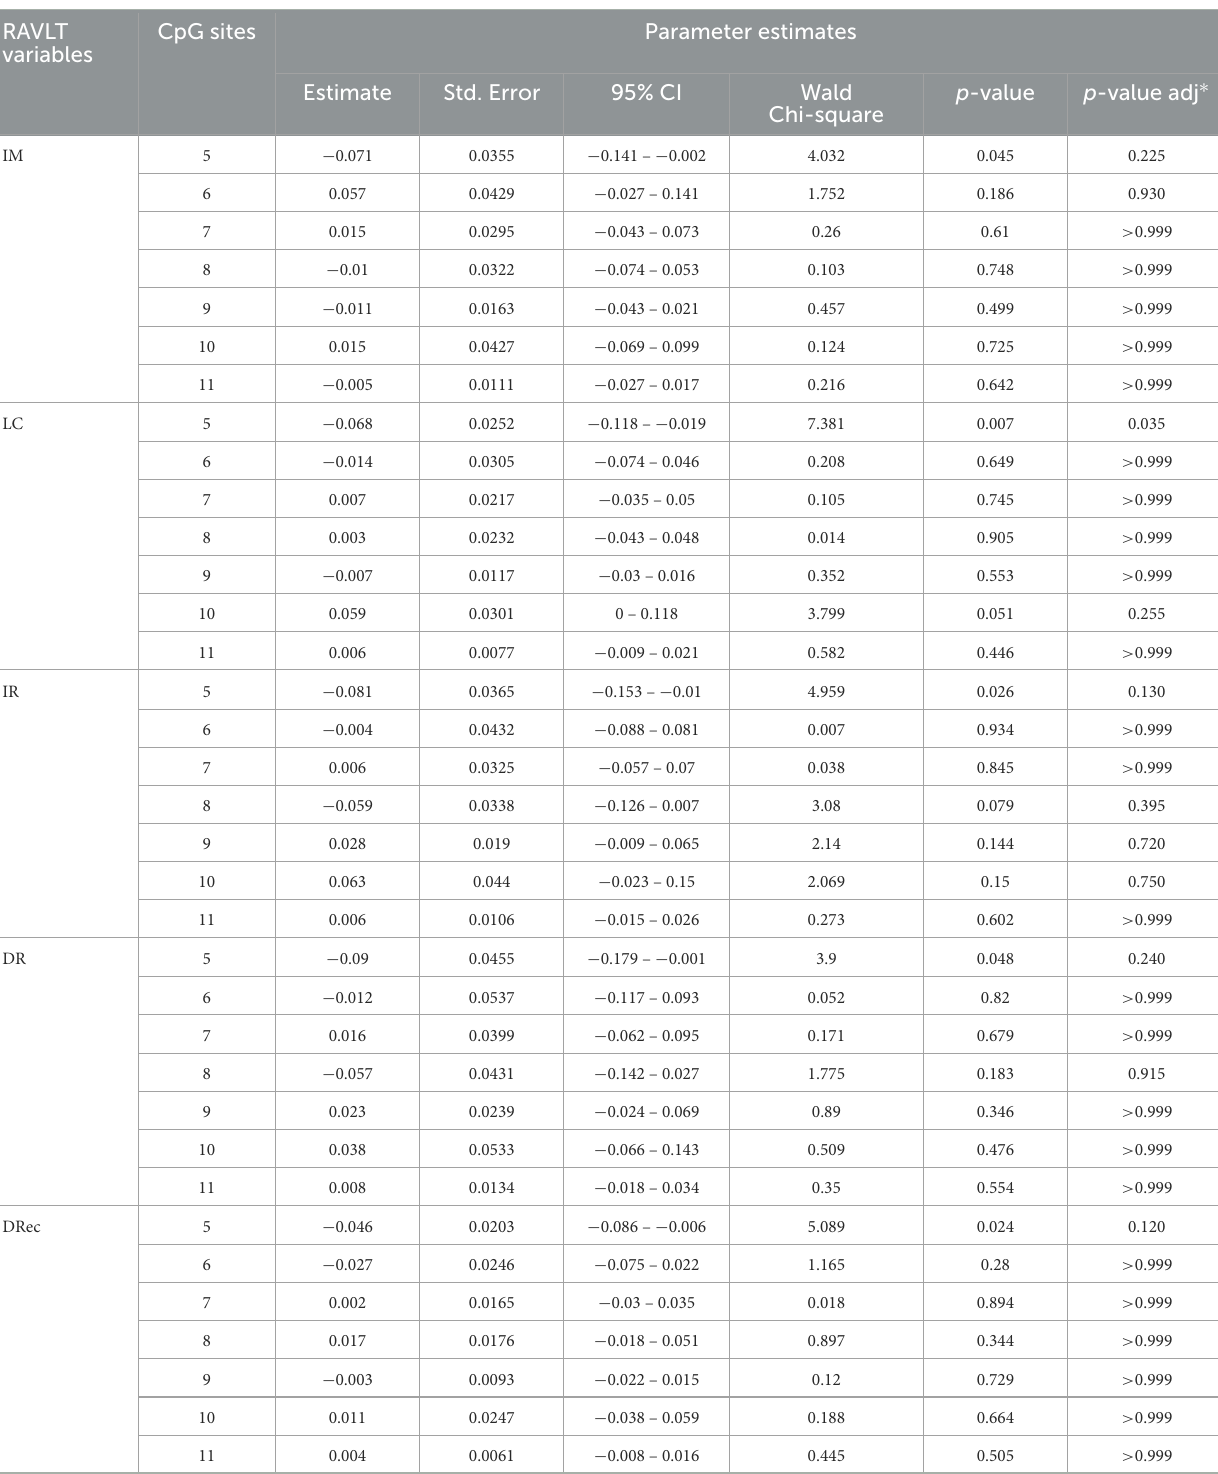
TABLE 2 GzLM results for models with all CpGs, ajusted by confounding factors: age, education, current andidepressive use, BMI, BDI-II scores, current smoking, current alcohol consumption, and physical activity. RAVLT